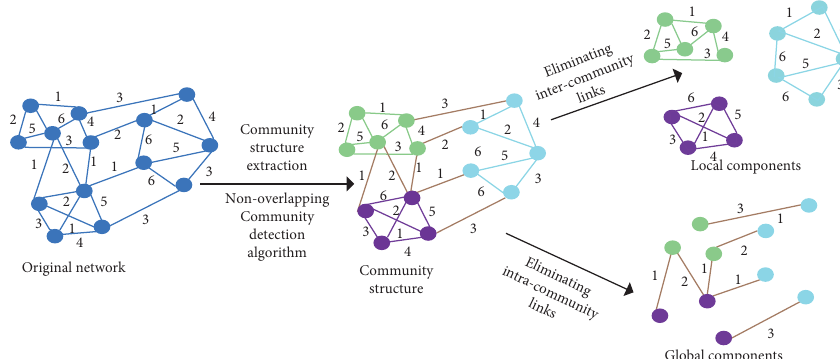
Figure 1: Tis fgure illustrates the process of uncovering the component structure using a community detection algorithm to extract the dense parts forming the local components. After revealing the local components, one builds the global components with the nodes and links shared by the local components. In this example, the network has three communities colored green, light blue, and dark blue. Terefore, it has three local components. Te links and nodes joining these local components form three global